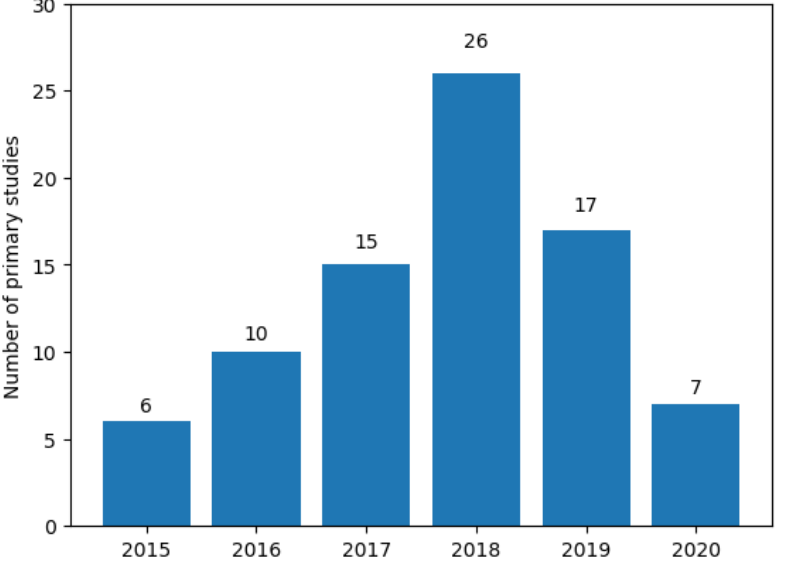
Figure 2. Articles distribution by publication